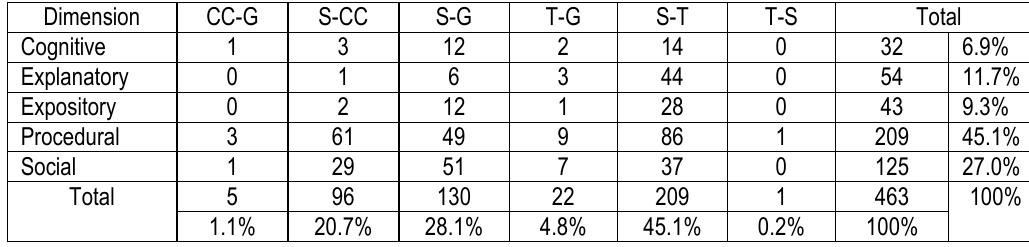
Table 5. SHTVU LMS: Number and Types of Interactions Dimension